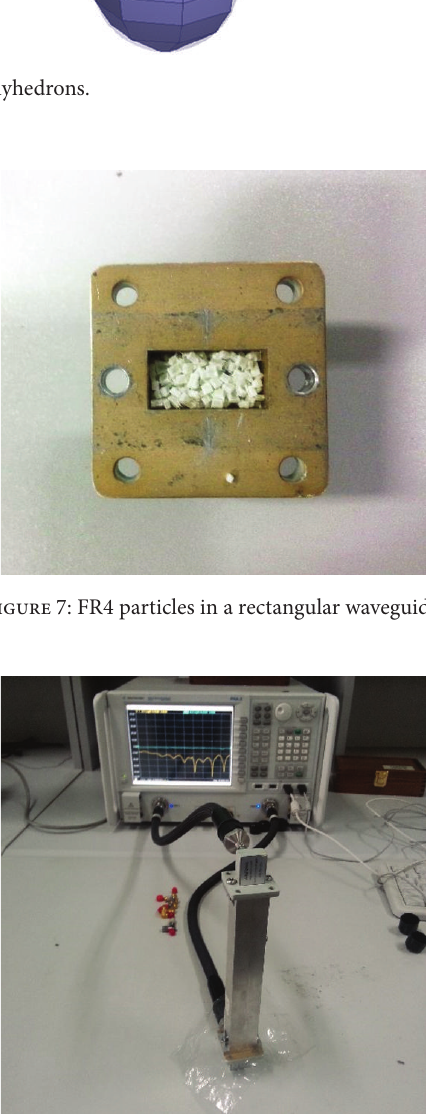
Figure 8: Measurement of electromagnetic properties of packing particles in the rectangular